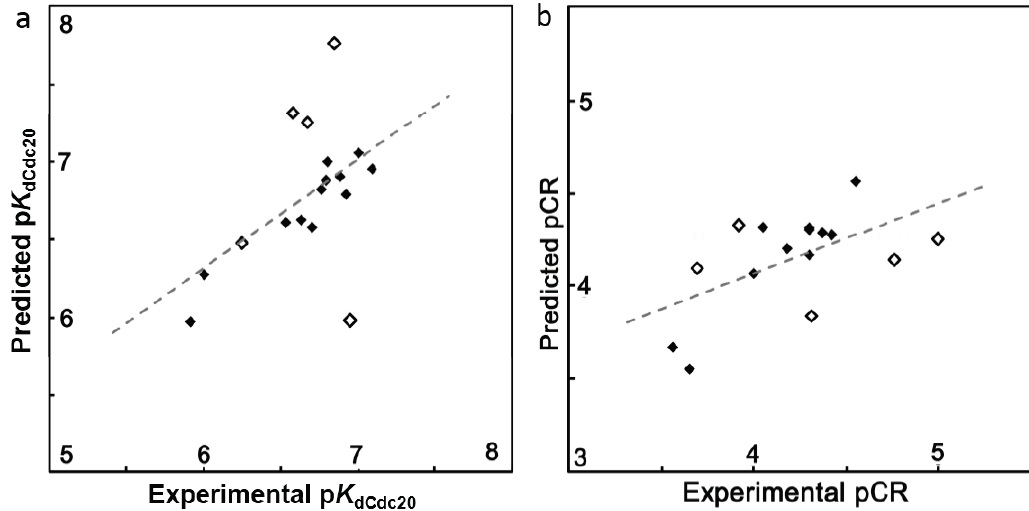
Figure 1. ( a ) Correlation between experimental and predicted binding of Mad2 native and mutants (p K dCdc20 ) obtained by QSAR model 2 ( q 2 = 0.65, r 2 = 0.83); and ( b ) correlation between experimental and predicted conversion rate of Mad2 native and mutants (pCR) obtained by QSAR model 3 ( q 2 = 0.60, r 2 = 0.90). Black dots correspond to molecules in the training set and white (open) dots to molecules in the test